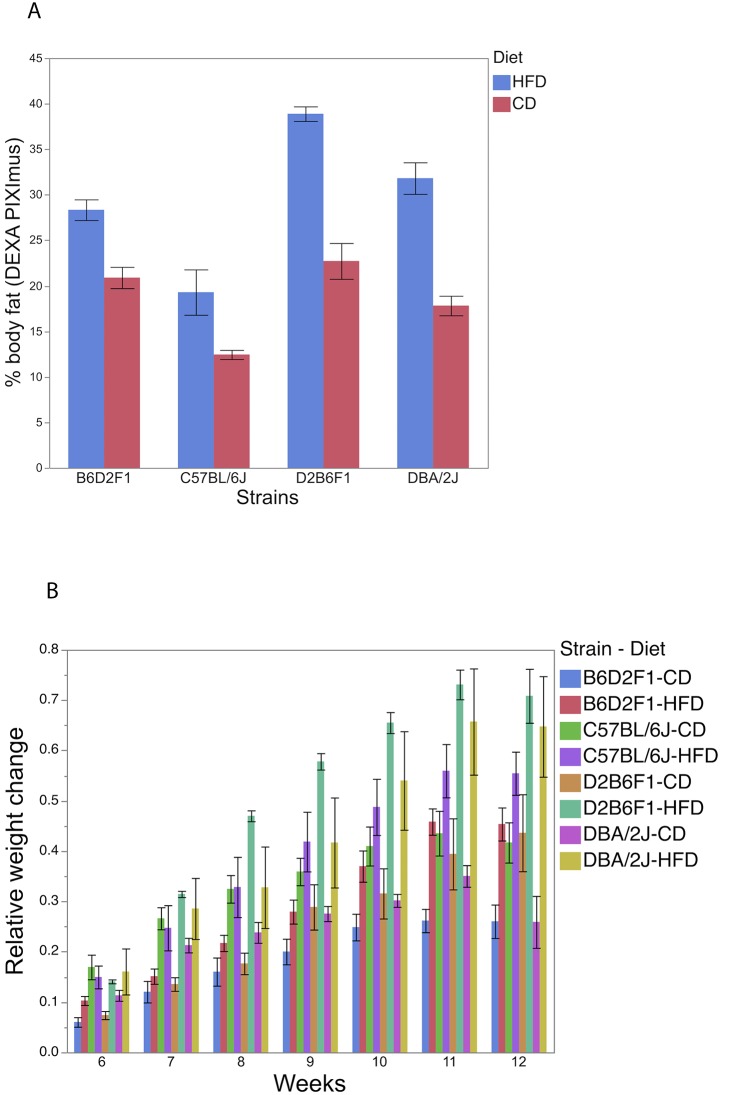
Proportion of body fat composition (12 weeks of age)(A) and changes in average body weight (g) relative to the start of dietary experiment (5 weeks of age)(B) in C57BL/6J, DBA/2J and their reciprocal F1 hybrids strains subjected to CD and HFD.